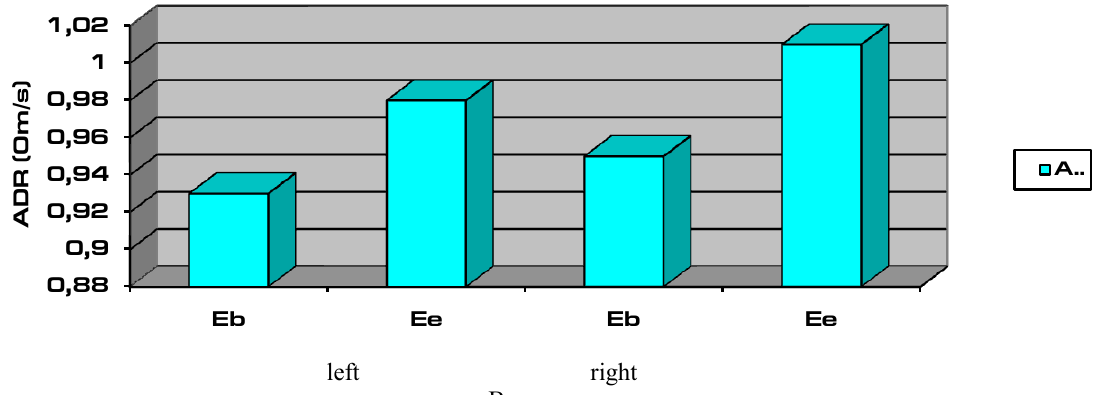
Figure 2. Indexes of filling by the blood of vessels of cerebrum (left and right hemisphere) with athletes (heavy athletics) before and after paravertebral miorelaxation (A - temporal indexes, B - amplitude-temporal indexes): TRF - time of the rapid filling, TGR - time of getting up of rheogram, Eb - beginning of experiment; Ee - end of experiment,